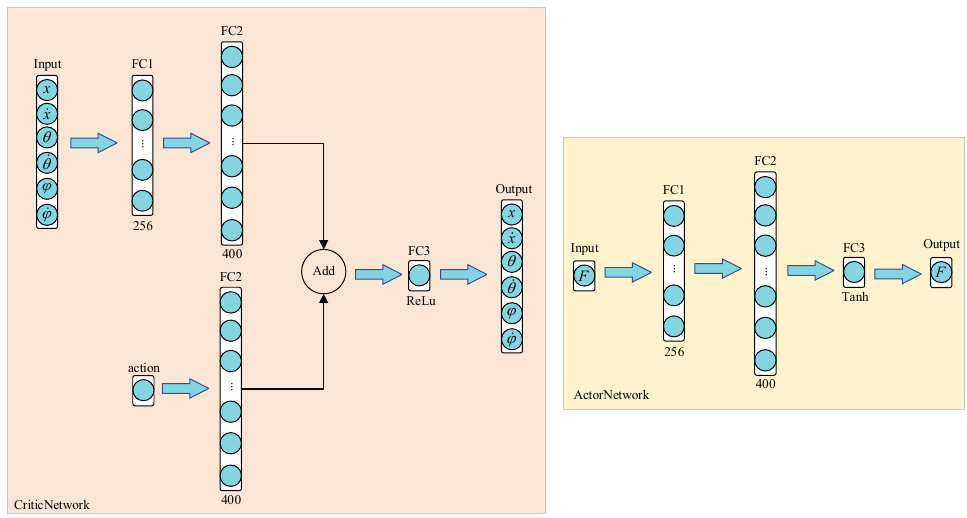
Figure 6. The learning network architecture of DDPG.